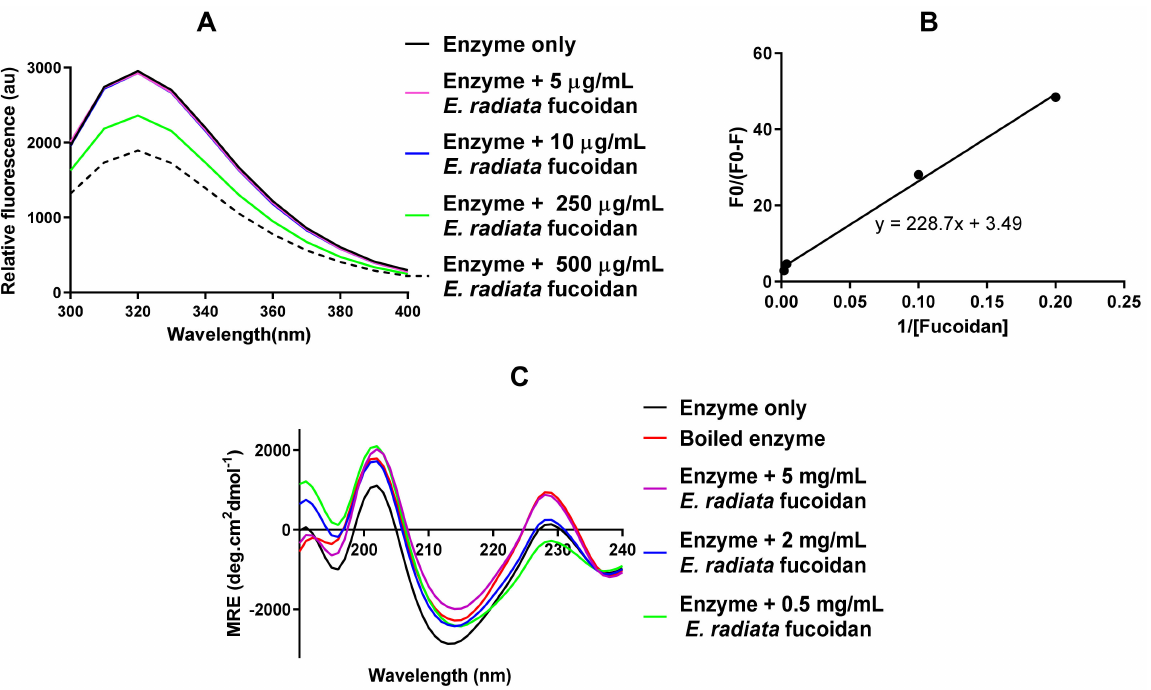
Figure 5. E. radiata fucoidan directly interacts with the α -glucosidase enzyme. ( A ) Fluorescence emission spectra of intrinsic fluorescent quenching of α -glucosidase in the presence of E. radiata fucoidan. ( B ) F0/(F0 − F) plot versus 1/[fucoidan] for the fucoidan- α -glucosidase complex. ( C ) Circular dichroism spectra showing changes in α -glucosidase econdary structure in the presence of E. radiata fucoidan. Values are represented as means ± SD ( n =